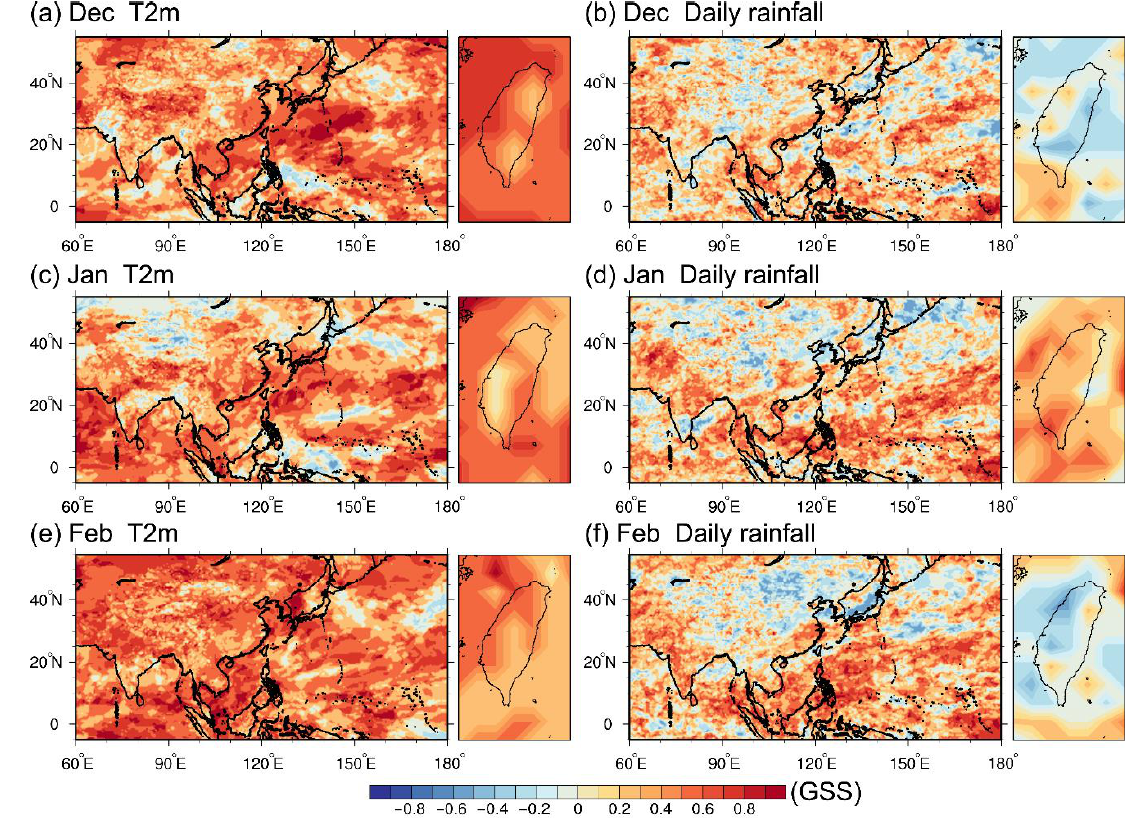
Figure 5. Gerrity skill score ( GSS ) of monthly averaged T2m (left column) and averaged daily rainfall (right column) on ( a , b ) December, ( c , d ) January, and ( e , f ) February. The zoom-in area of Taiwan is listed on the right panel of each figure.